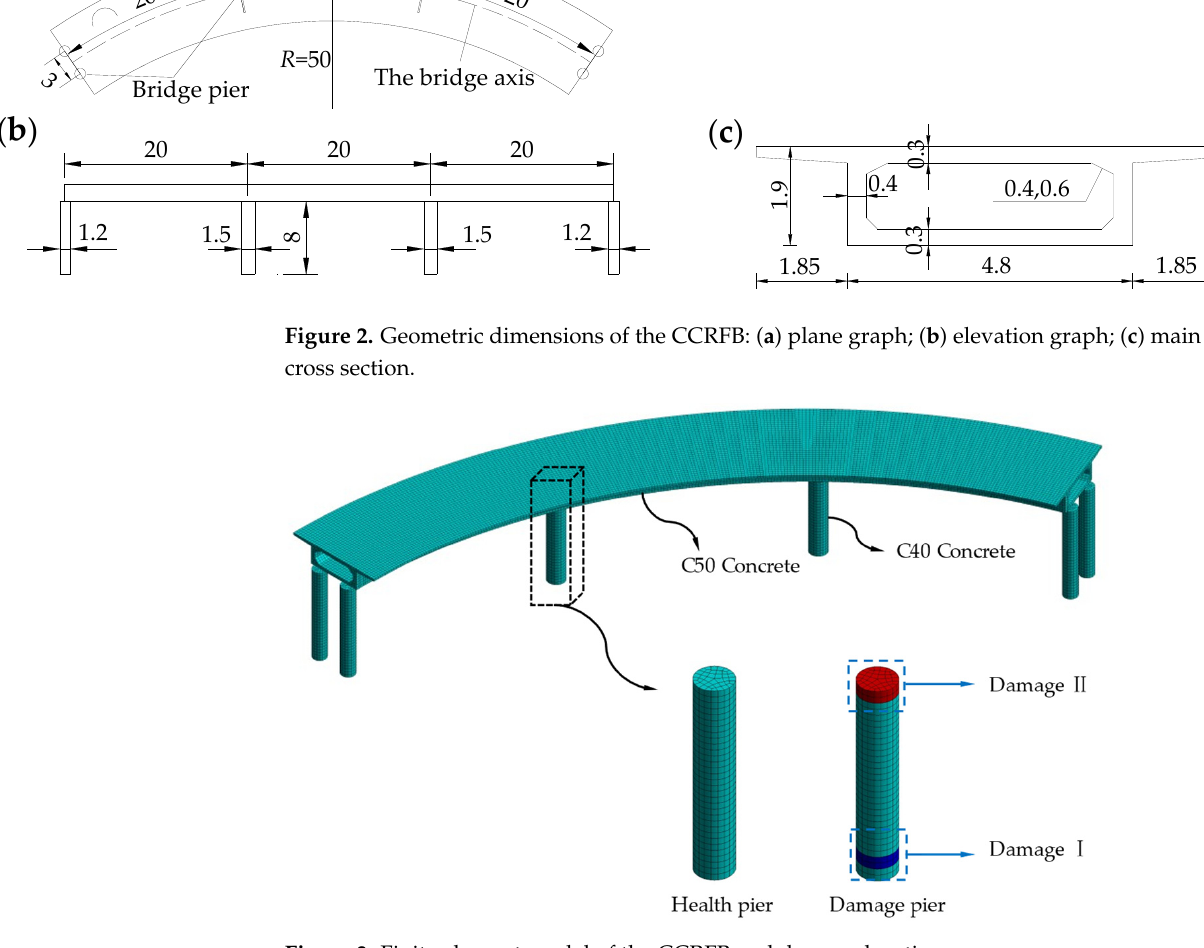
Figure 3. Finite element model of the CCRFB and damage locations.